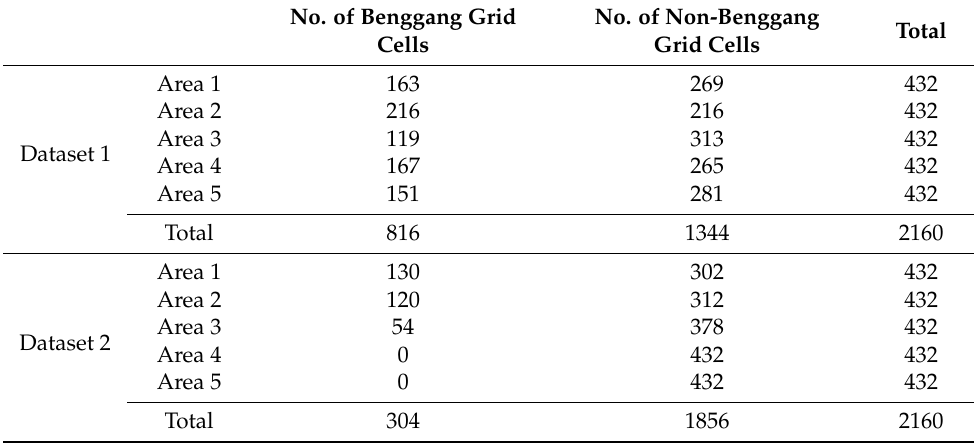
Table 1. Summary of the datasets used in the